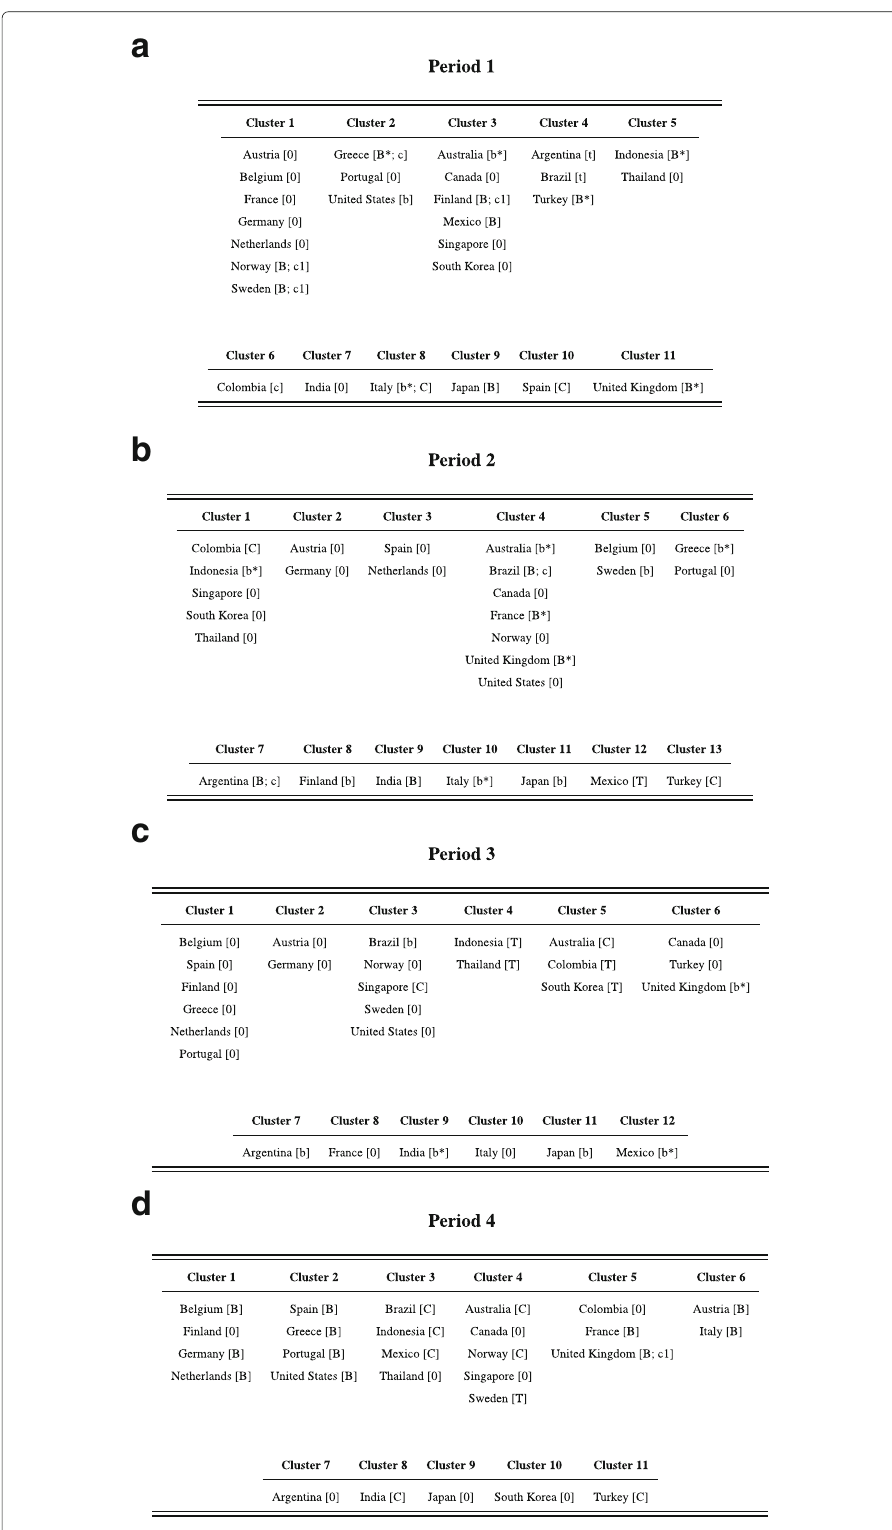
Fig. 1 Targeted Cluster-Composition: